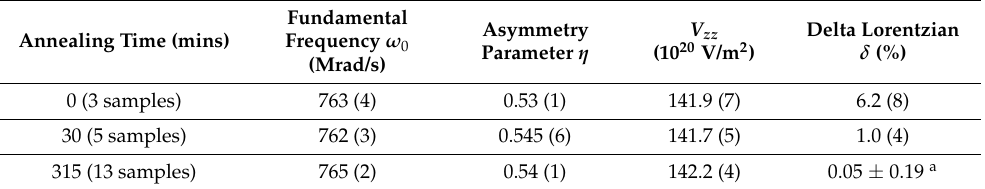
Table A3. Collecting the averaged results of our experimental and hyperfine parameters tailored to the time length of the annealing process (temperature of 873 K in vacuum). We principally want to point out the rapidly decreasing Delta Lorentzian δ , as a measure of the restoration of the lattice structure (at least around the 181 Ta probes located at the Ti-substitutional site with a D 2h site symmetry) that was caused by the 80 keV 181 Hf implanted ions. (a) The averaged δ is written in this form, as its uncertainty exceeds its